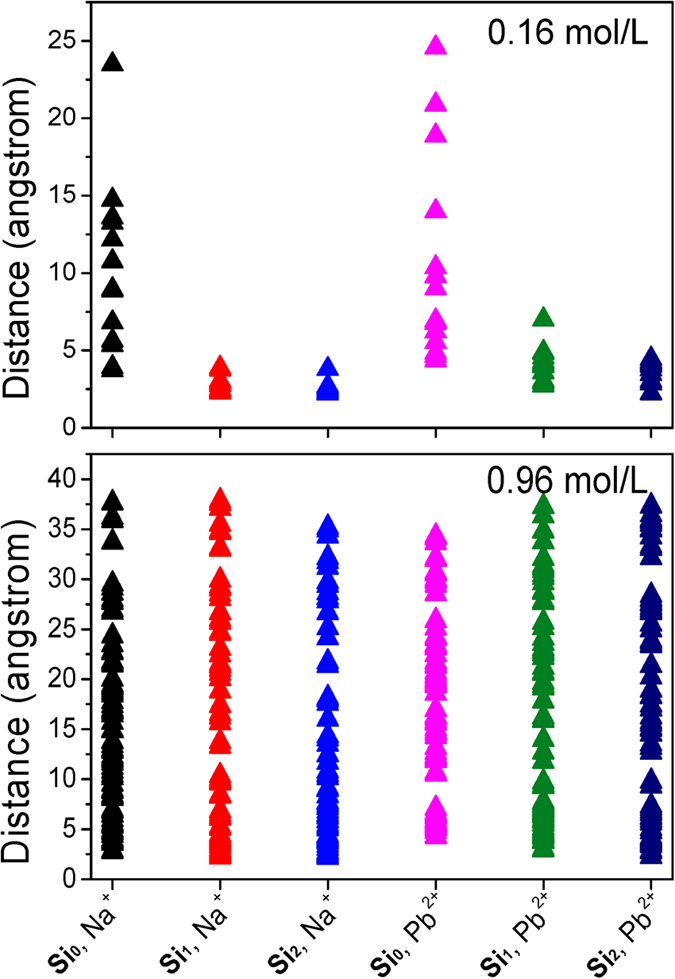
Distances between the tetrahedral SiO4 surfaces of kaolinite and Na+/Pb2+ ions from NaCl/PbCl2 solutions.